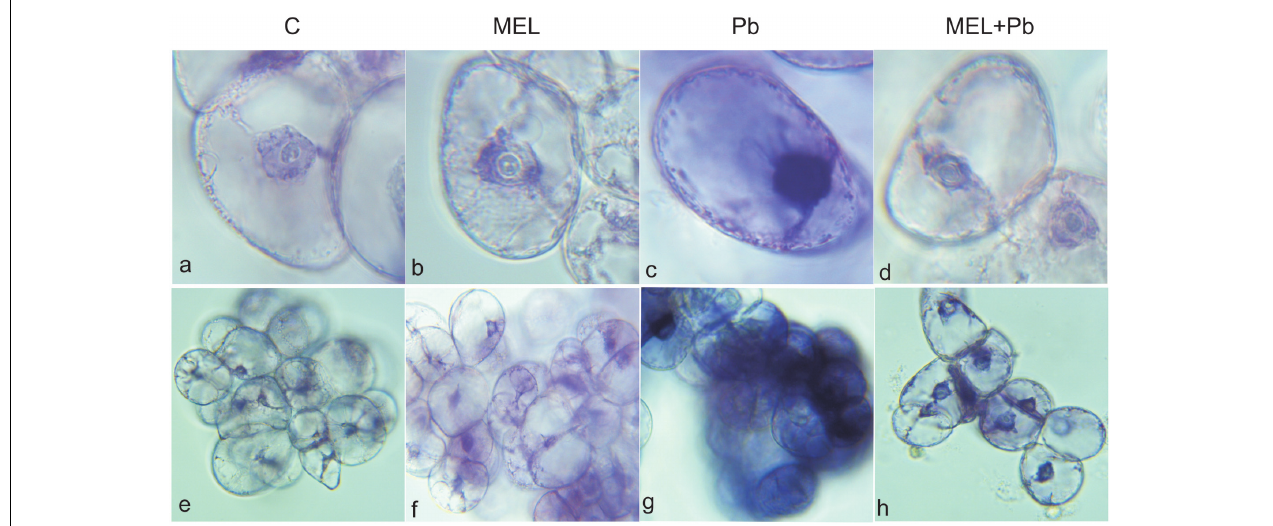
FIGURE 6 | Superoxide anions detected by NBT staining in tobacco BY-2 cells. The cells were stained 4 h after lead administration. C, BY-2 cells cultured on LS medium – the control variant; MEL, BY-2 cells cultured on LS medium with 200 nM melatonin added from the beginning of the culture; Pb, BY-2 cells cultured on LS medium with 15 µ M Pb 2 + added on the 4th day of culture and MEL + Pb, BY-2 cells cultured on LS medium with melatonin added from the start of the culture and with Pb 2 + added on the 4th day of culture. BY-2 cells zoomed × 1000 (a–d) and × 100 (e–h) .